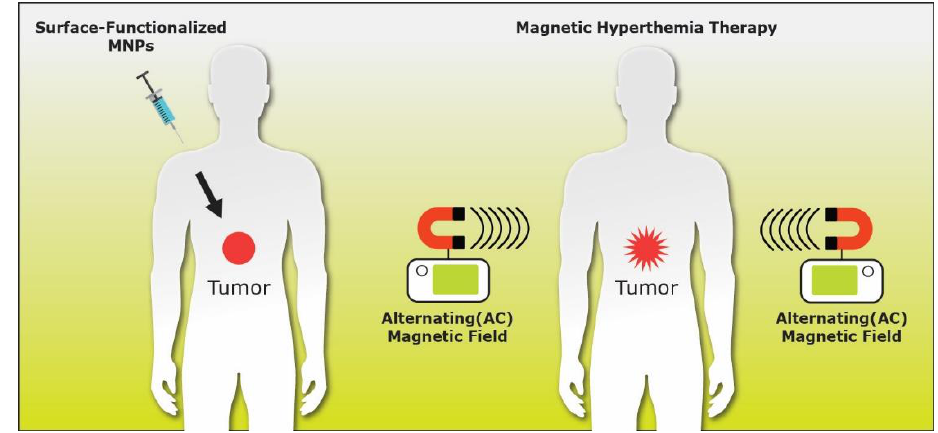
Figure 12. Illustration of a typical magnetic hyperthermia therapy process.